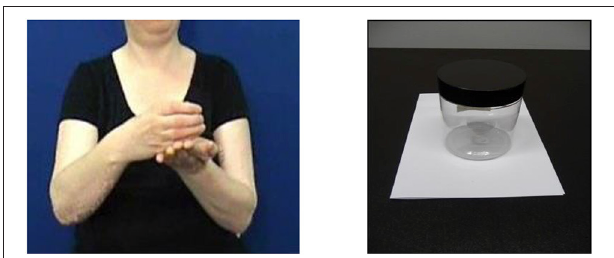
FIGURE 1 | (A) CL-CURVED-OBJECT ON CL-FLAT-OBJECT. (B) Jar on sheet of